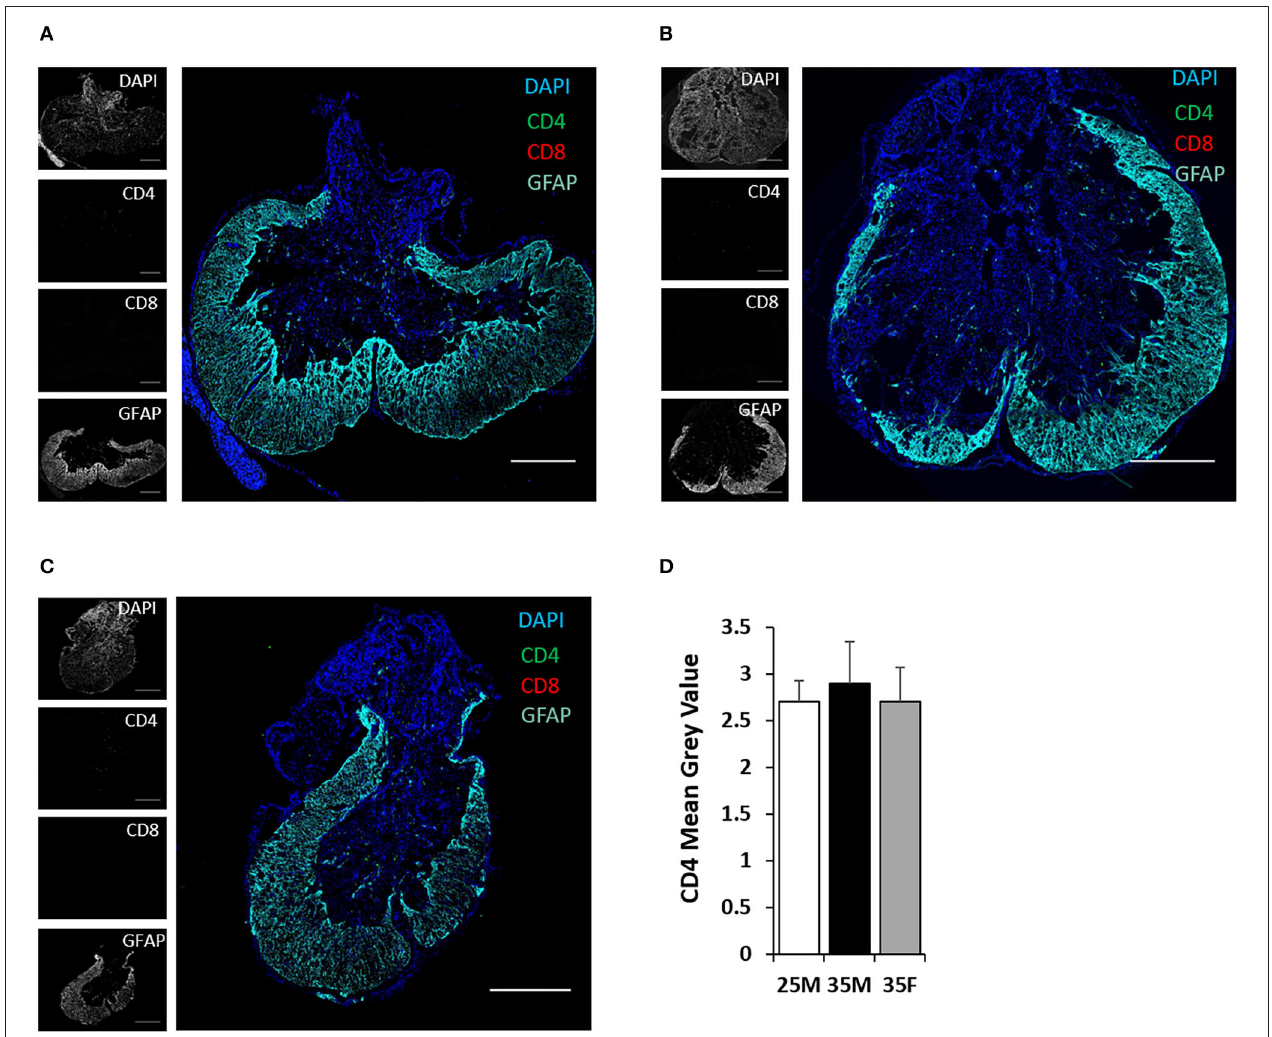
FIGURE 7 | CD4 and CD8T cells at the lesion epicenter following SCI. (A–C) Fluorescent images of the lesion epicenter of 25M (A) , 35M (B) , and 35F (C) groups, DAPI (blue), CD4 (green), CD8 (red), and GFAP (teal). (D) Quantification of fluorescence intensities of CD4 at the lesion epicenter. Data are presented as mean + SEM. Scale bar shows 500 µ